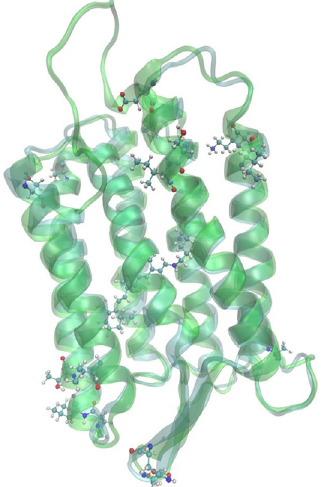
Figure 3. The illustration of the differences between structures of archaerhodopsin-1 and archaerhodopsin-3.